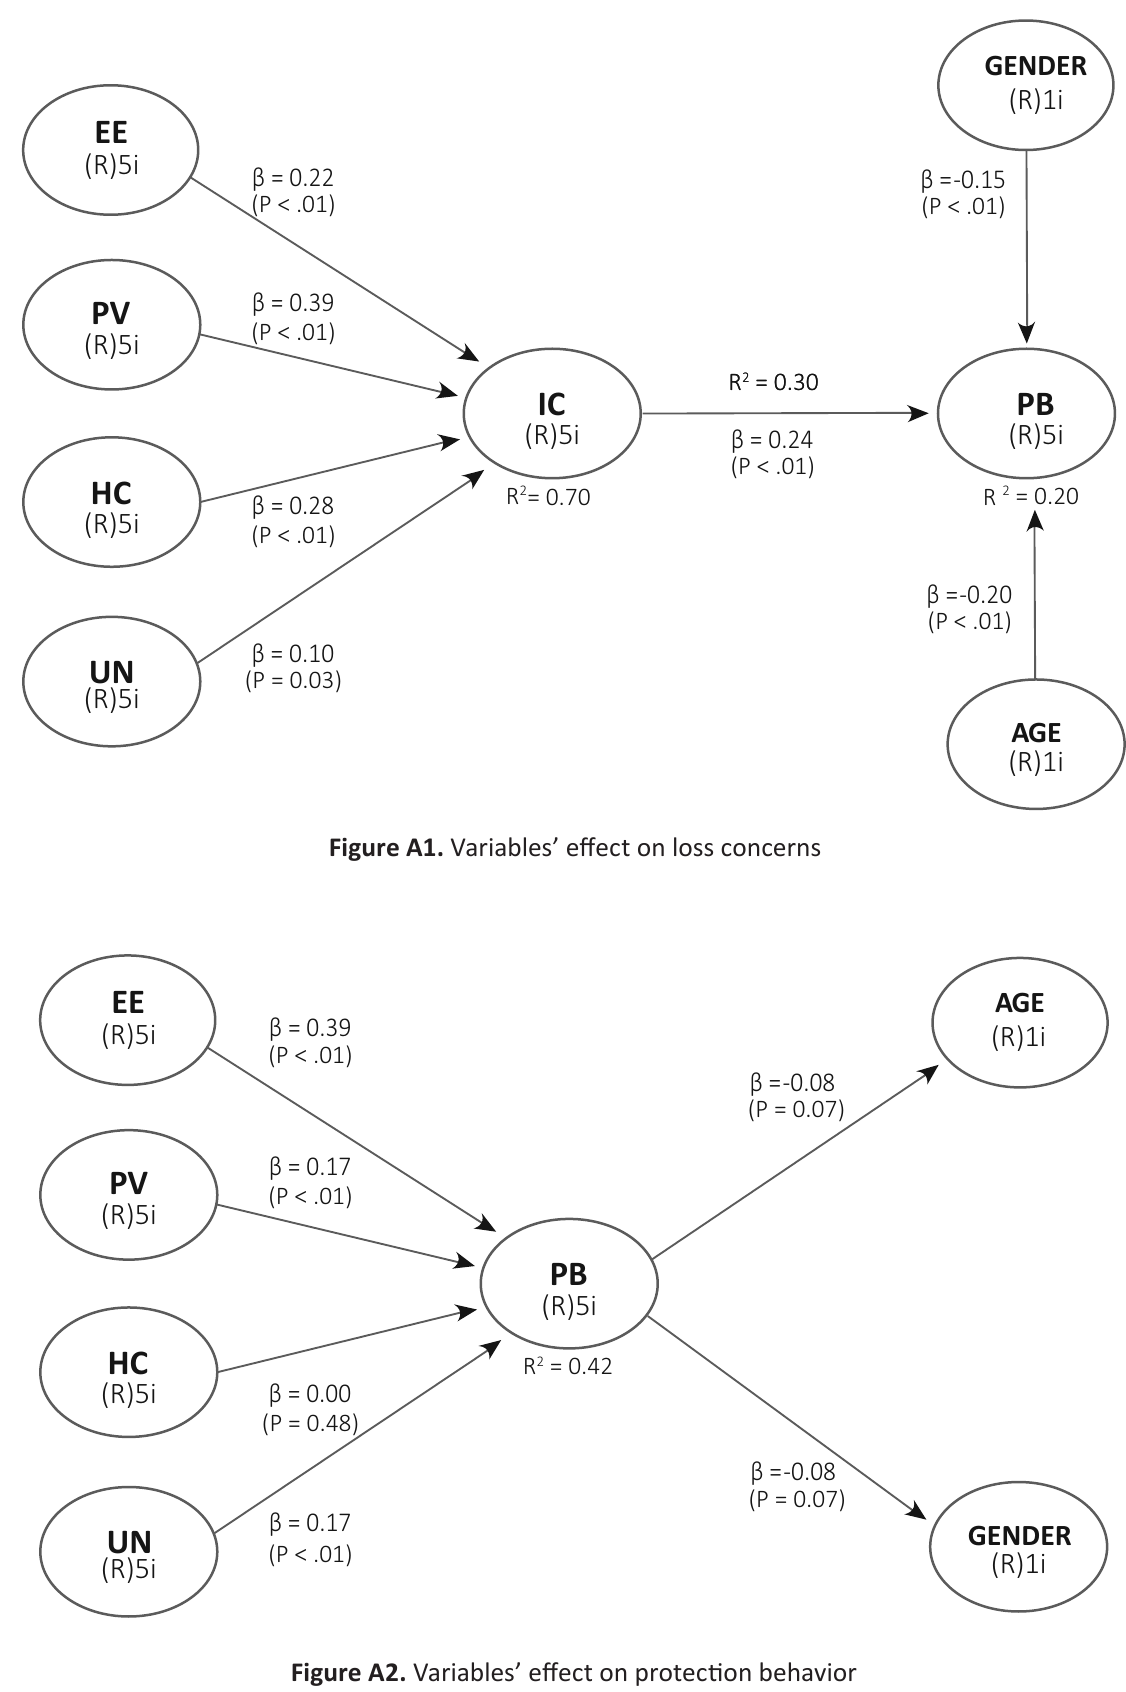
Figure A2. Variables’ effect on protection